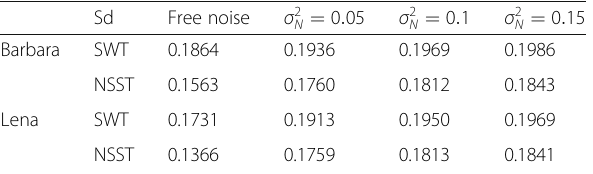
Table 1 The Sd parameter for noise-free image and three different noise power